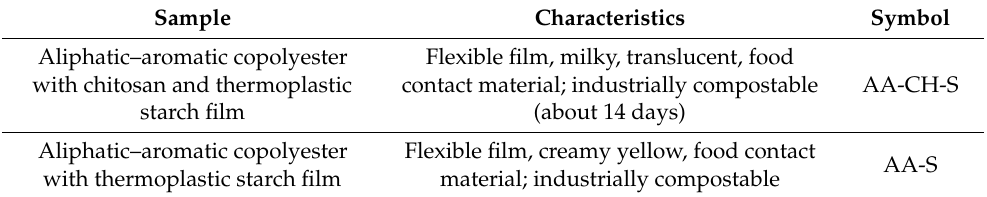
Table 1. Samples’ description. Sample Characteristics Symbol Aliphatic–aromatic